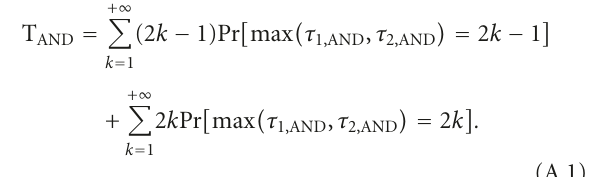
( σ p 2 /σ p 1 ) and 10